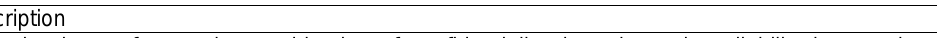
Table 1. Different types of healthcare information loss